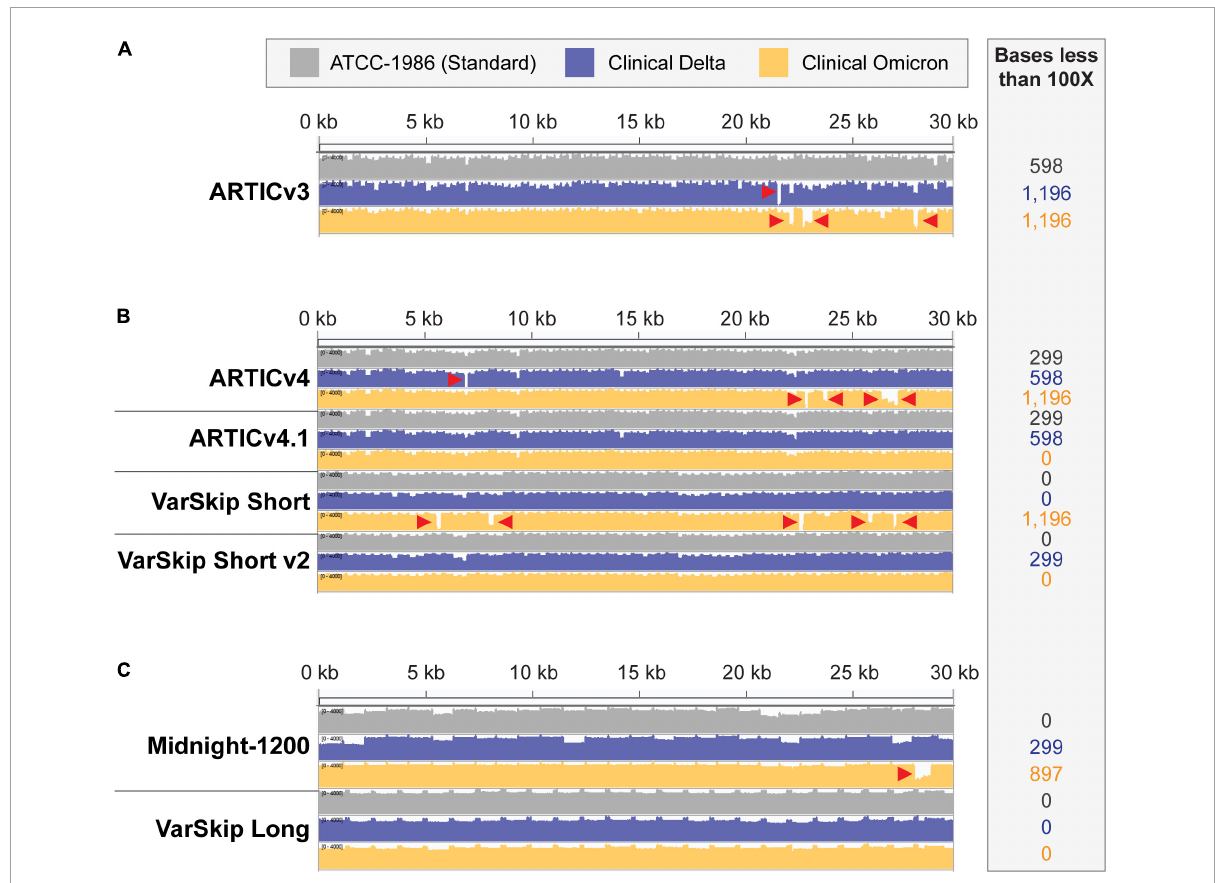
FIGURE2 SARS-CoV-2 standard and variant genome coverage improves with multi-reference-based primer schemes. Integrative Genome Viewer visualization of read coverage across the SARS-CoV-2 genome (0–4,000 log scale). Genome coverage tracks for ATCC-1986 standard Wuhan-1 cultured RNA control templates in gray, clinical Delta sample templates in blue, and clinical Omicron sample templates in orange. Red arrowheads point to amplicon dropouts with < 100 × coverage. The number of bases with less than 100 × coverage are listed in the inset beside each genome coverage track. (A) Coverage of the SARS-CoV-2 genomes with ARTICv3 primers. (B) Coverage of SARS-CoV-2 genomes with ARTIC v4, ARTIC v4.1, VarSkip Short, and VarSkip Short v2 primers. (C) Coverage of SARS-CoV-2 genomes with Midnight-1200 and VarSkip Long